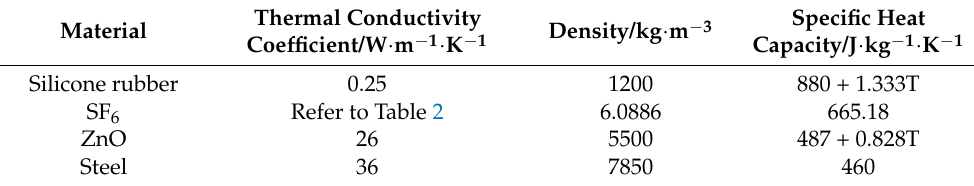
Table 2. The thermal conductivity coefficient variation of SF 6 with respect to the temperature. Table 1. The material property settings of the four-column parallel zinc oxide arrester material. T